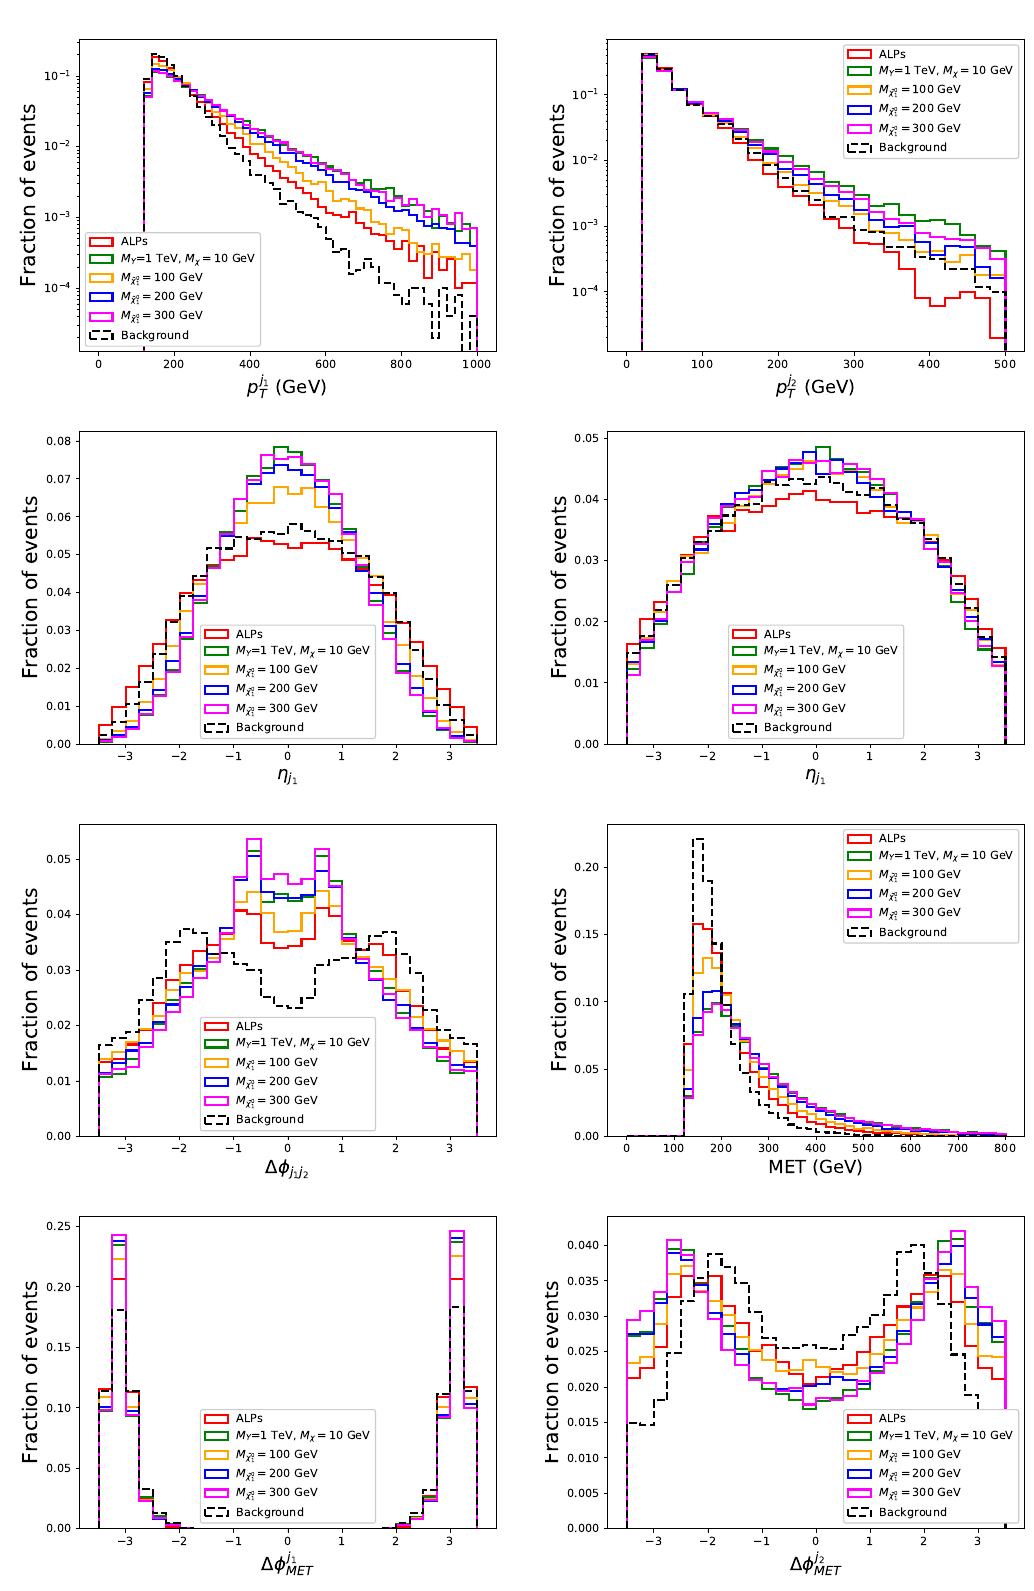
Figure 3: Detector-level 1D histograms for the dijet process for WIMP, EFT and ALP scenarios, as well as the SM